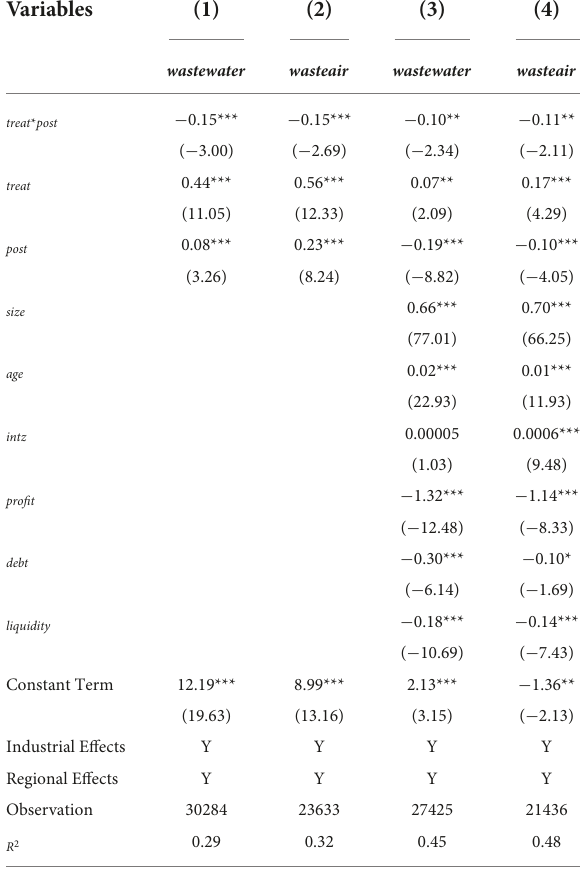
TABLE 2 Baseline regression results.